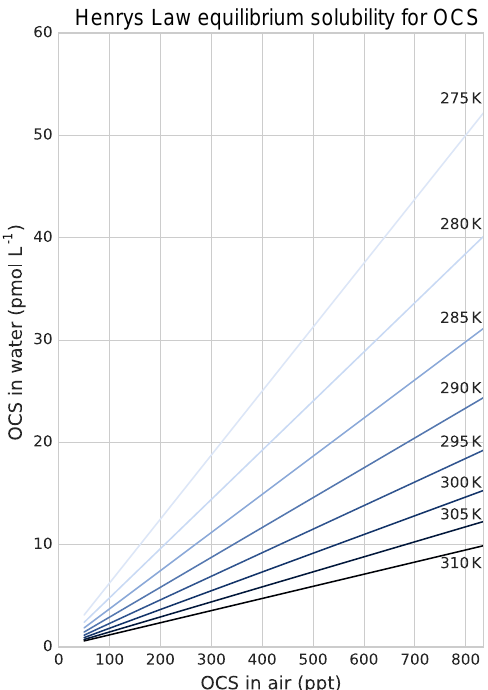
Figure 5. Solubility of OCS in water dependent on ambient OCS concentration and temperature as calculated in Sun et al. (2015).